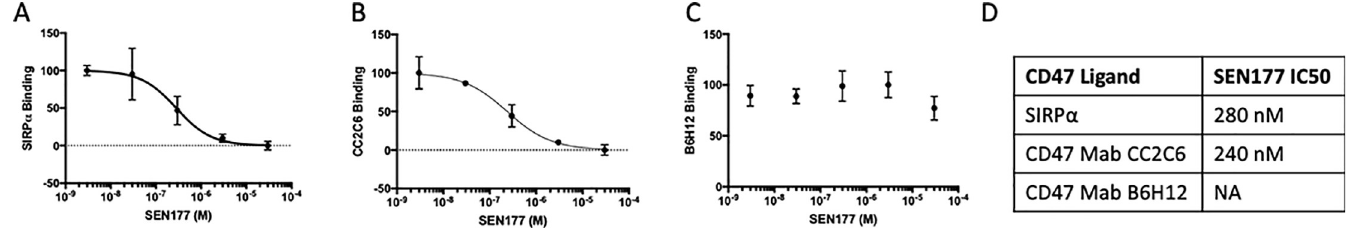
Fig 7. The LSC assay can be used to measure SIRP α binding sensitivity to CD47 pyroglutamate modification. (A) A2058 melanoma cells were treated with a range of concentrations of SEN177 for 48 hours and SIRP α binding quantified using the LSC assay. (B) Anti-CD47 clone CC2C6 or (C) clone B6H12 reactivity for the same samples as in panel A. The IC50 value is indicated where measurable. Data represents n = 3 replicates measurements for 3 separate experiments.